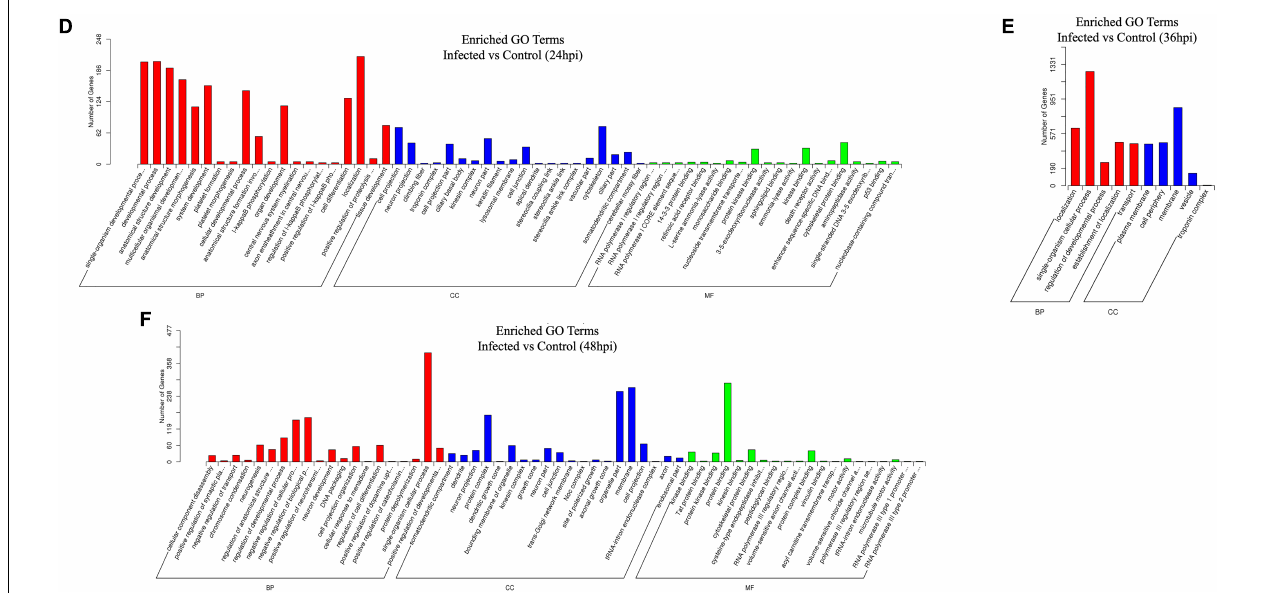
FIGURE 5 | (A–F) Gene Ontology (GO) enrichment histogram of candidate target genes between the infected and control groups from 0 to 48 hpi. The proportions of the three categories of GO [biological process (BP), cellular component (CC), and molecular function (MF)] and the number of candidate target genes annotated are shown.